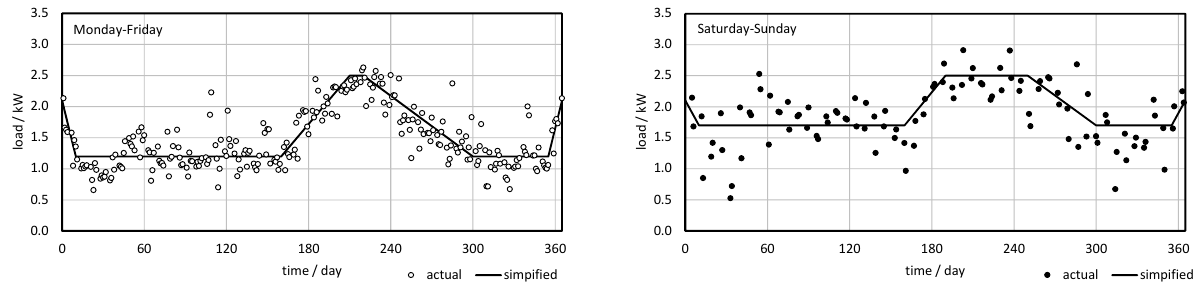
Figure 7. Comparison of the actual and proposed simplified normalized maximum loads.